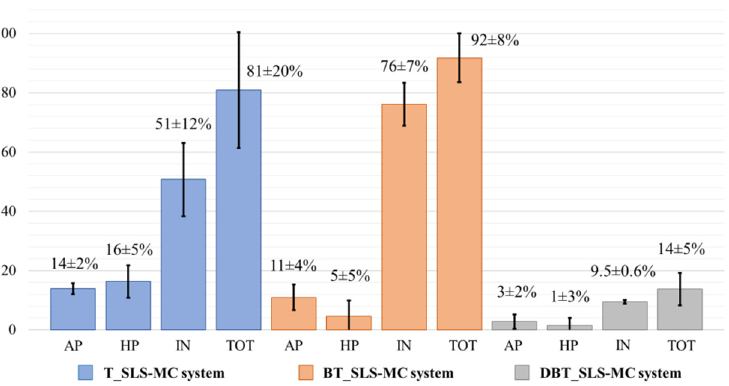
Figure 5. Comparison of quantities of active in aqueous phase (AP), hexane phase (HP) corresponding to surface-bound active (SBA), inside capsules (IN) and overall sum (TOT) for SLS-MCs containing unprotected thymol and derivatives. Data are presented as percentage ± standard deviation over three batches.